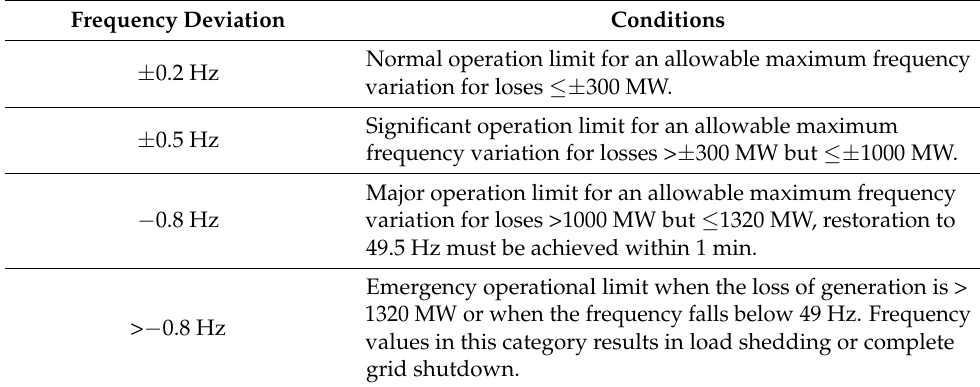
Table 1. Frequency containment policy of the UK National